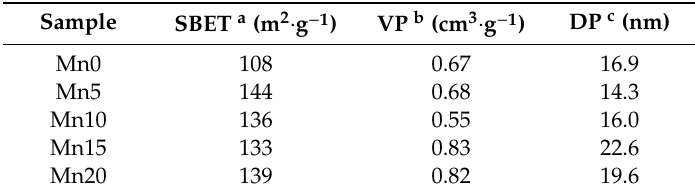
Table 2. Textural properties of the oxide